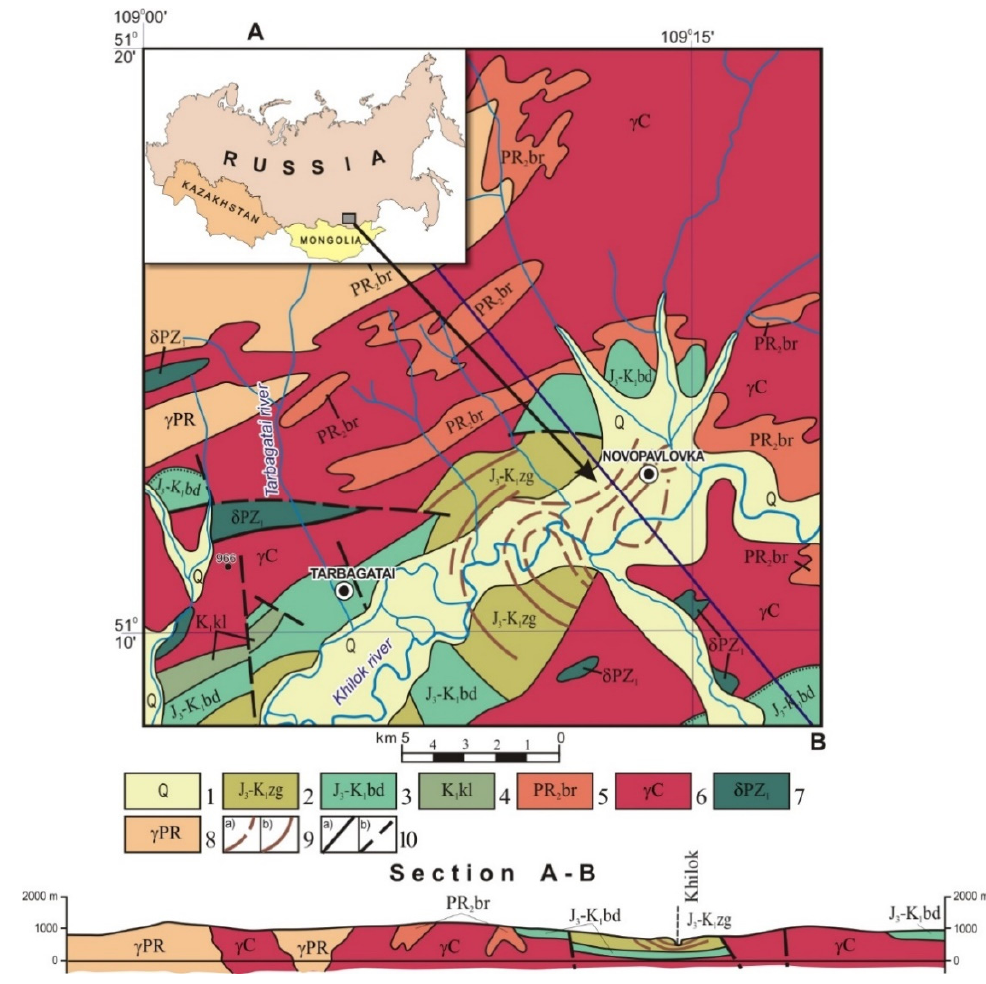
Figure 2. Geological map of the Tarbagatai deposit area [33]. Note: 1—Quaternary system., alluvial sand, gravel, and loam.; 2—Upper Jurassic—Lower Cretaceous, Zugmar Formation, sandstone, siltstone, mudstone, conglomerates, and coal; 3—Upper Jurassic—Lower Cretaceous, Badin For- mation, sandstone, siltstone, conglomerates, and basaltic-trachyandesite; 4—Cretaceous system, Kulevskaya Formation, siltstone, mudstone, sandstone, and coal; 5—Proterozoic, Berezovaya For- mation, biotite, biotite-amphibole crystalline schist and gneiss; 6—Carboniferous system, fine-grained, leucocratic granites; 7—Lower Paleozoic, diorite; 8—Proterozoic, granite, gneissic granite; 9—Coal seams: (a) hidden under alluvial quaternary deposits, (b) traced on the surface; 10—Fractures: (a) found, (b) assumed.